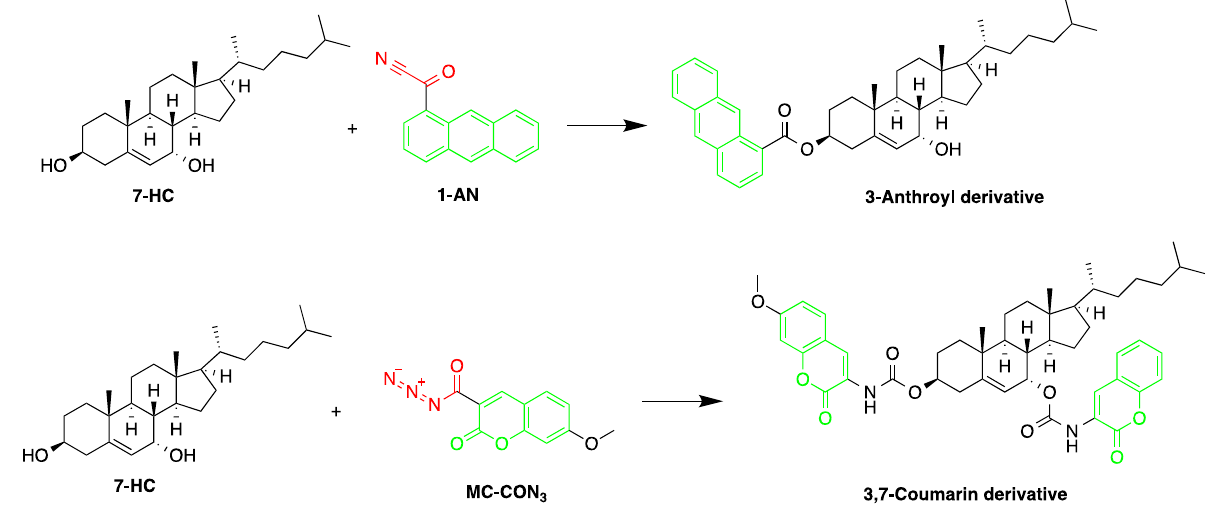
Figure 11. Derivatization of 7 α -hydroxycholesterol (7-HC) by 1-anthroyl nitrile (1-AN) or 7-methoxycoumarin-3-carbonyl azide (MC-CON 3 ).